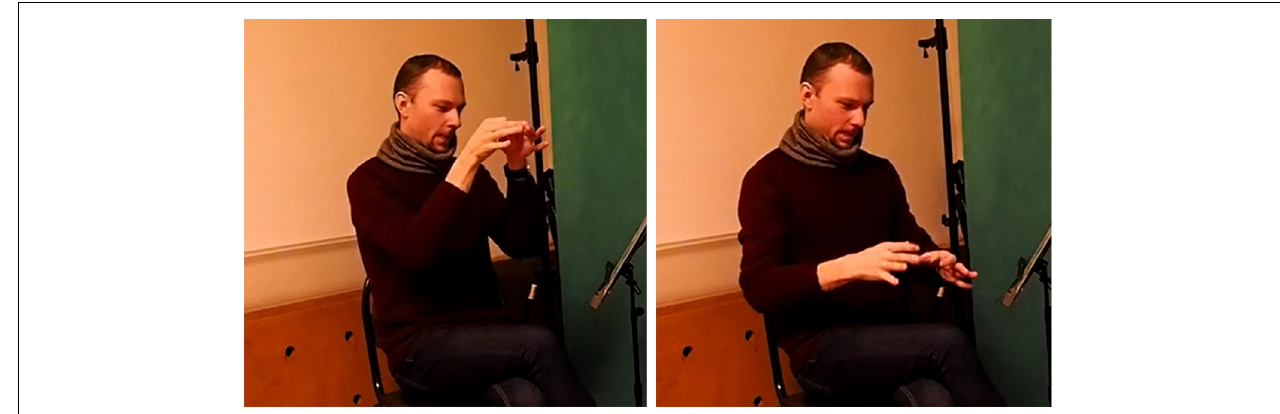
FIGURE 7 | SASS:tall-vertical-conical (about a vase).